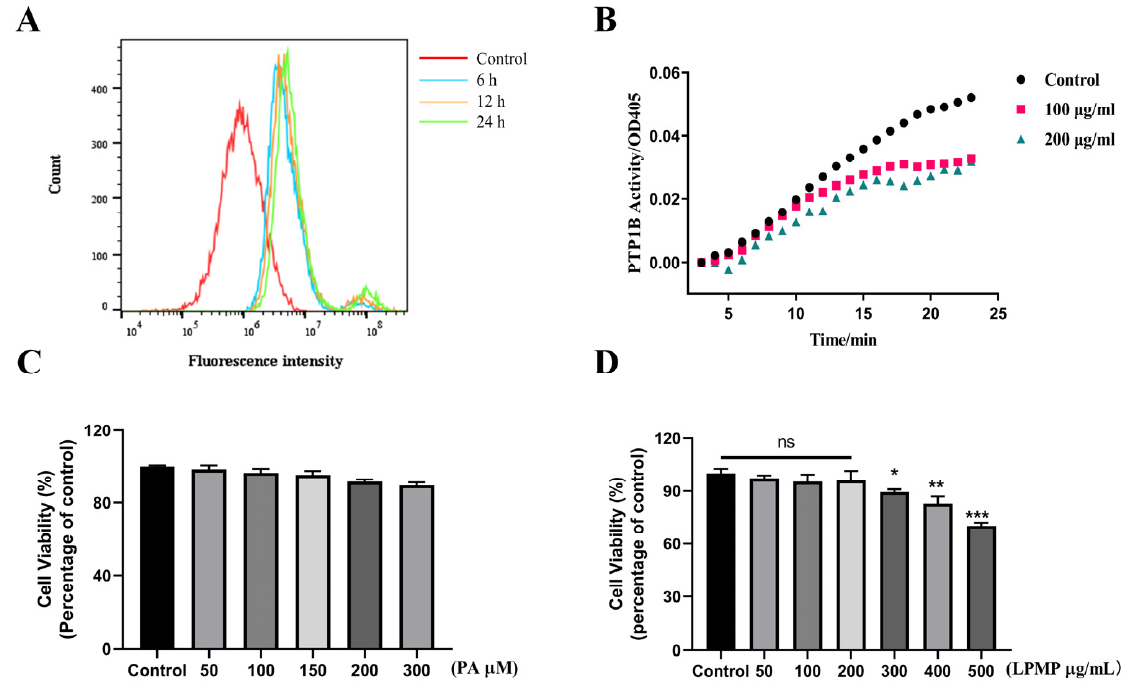
Figure 3. The cellular permeability and toxicity of LPMP in HepG2 hepatocytes. ( A ) HepG2 cells were assayed by flow cytometry for fluorescence levels of FITC after various periods of treatment with LPMP-FITC (200 μ g·mL − 1 ). ( B ) The effect of LPMP on the catalytic activity of PTP1B protein in HepG2 cells. The intracellular PTP1B protease activity was measured at different administration periods of 100 and 200 μ g·mL − 1 LPMP. ( C ) Cytotoxicity of sodium palmitate on HepG2 cells in the absence or presence of 50, 100, 150, 200, and 300 μ g·mL − 1 of PA for 24 h at 37 °C. ( D ) Cytotoxicity of LPMP on HepG2 cells in the absence or presence of 50, 100, 200, 300, 400, and 500 μ g·mL − 1 of LPMP for 24 h at 37 °C. Data are presented as means ± SEM ( n = 5). * p < 0.05, ** p < 0.01, *** p < 0.001 versus control group.